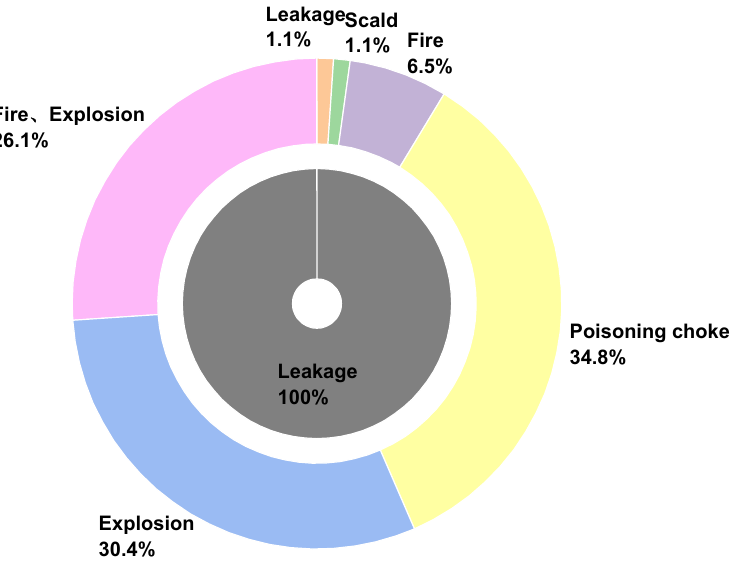
Figure 8. Percentage of accidents caused by leakage.